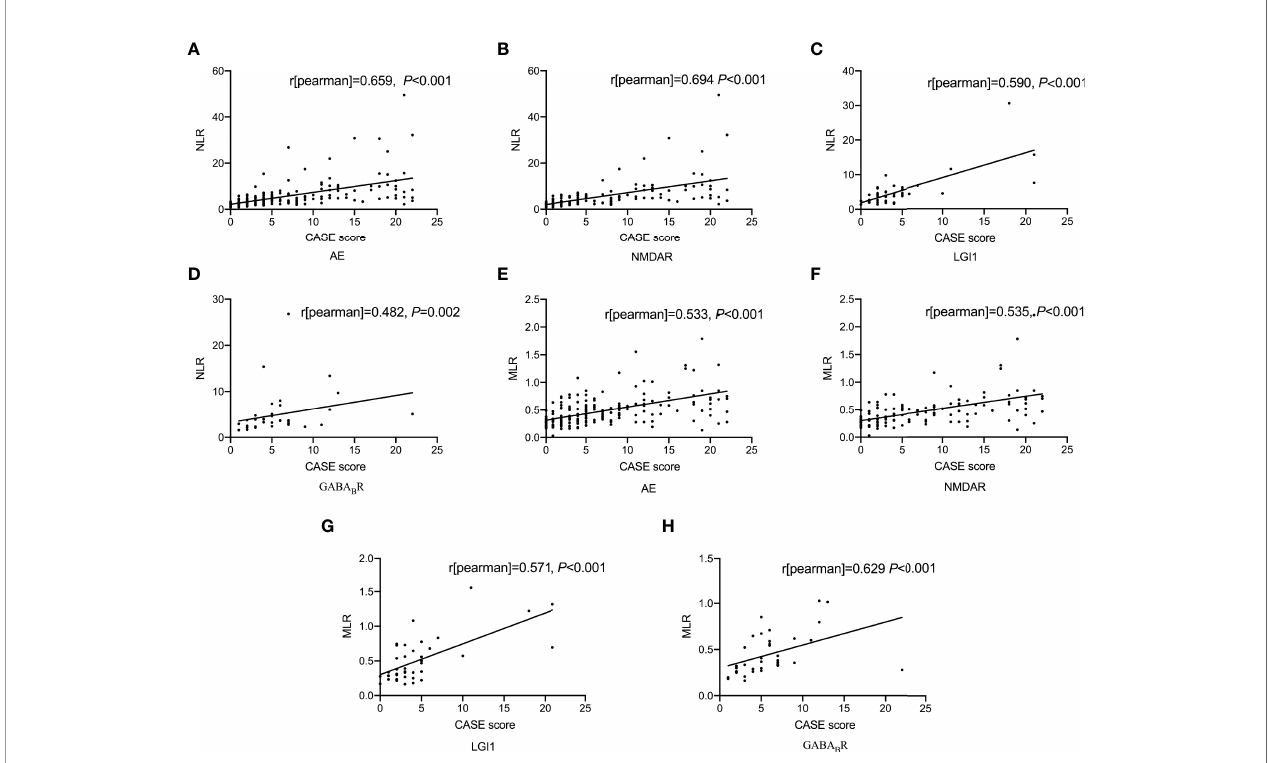
FIGURE 1 | Correlations of NLR and MLR with the CASE score. Correlation between NLR and the CASE score (A-D) ; Correlation between MLR and the CASE score (E-H) . AE, autoimmune encephalitis; NMDAR, N-methyl-D-aspartate receptor; LGI1, leucine-rich glioma inactivated 1; GABA B R, g -aminobutyric acid type B receptor; CASE, The Clinical Assessment Scale for Autoimmune Encephalitis; NLR, neutrophil-to-lymphocyte ratio; MLR, monocyte-to-lymphocyte